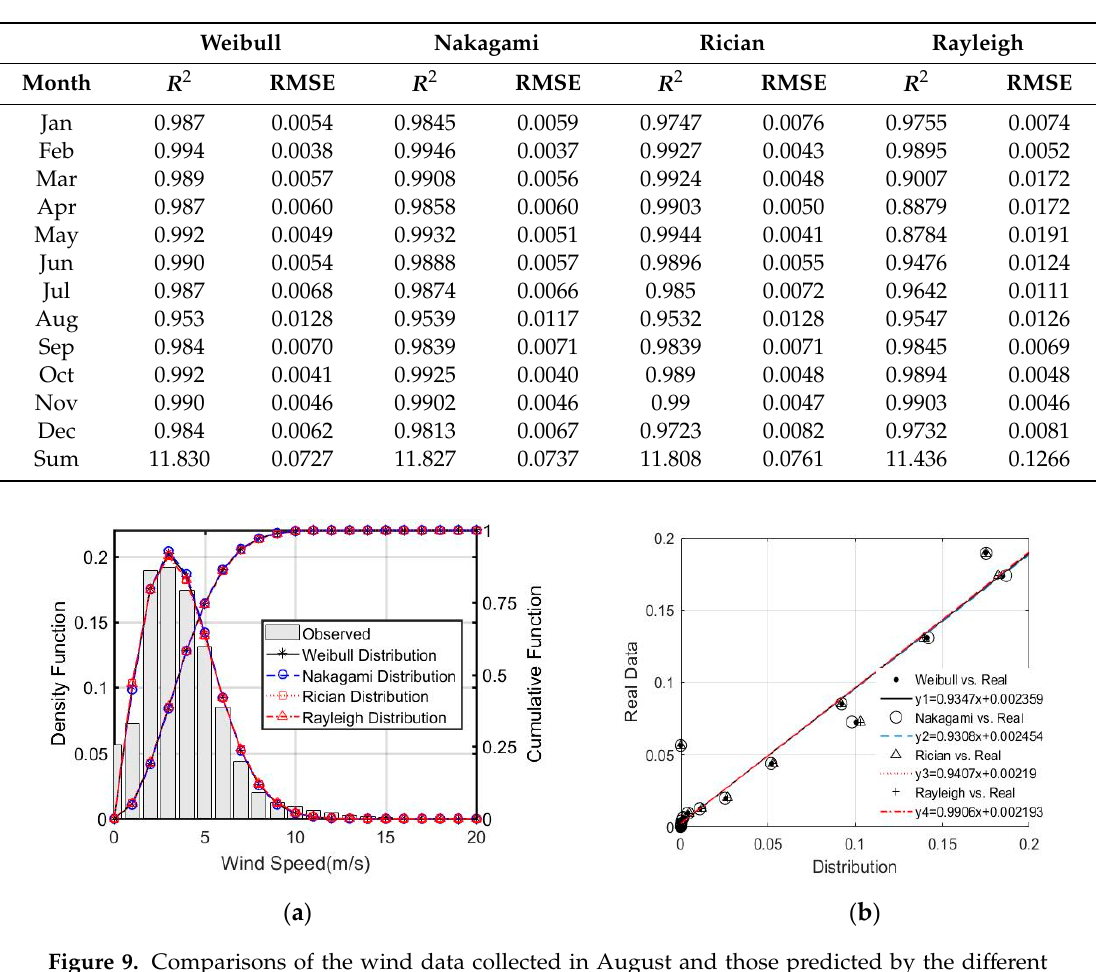
Figure 9. Comparisons of the wind data collected in August and those predicted by the different distributions. ( a ) Wind distribution in August against the four PDFs and CDFs; ( b ) Q–Q plot between the real data and four PDFs.